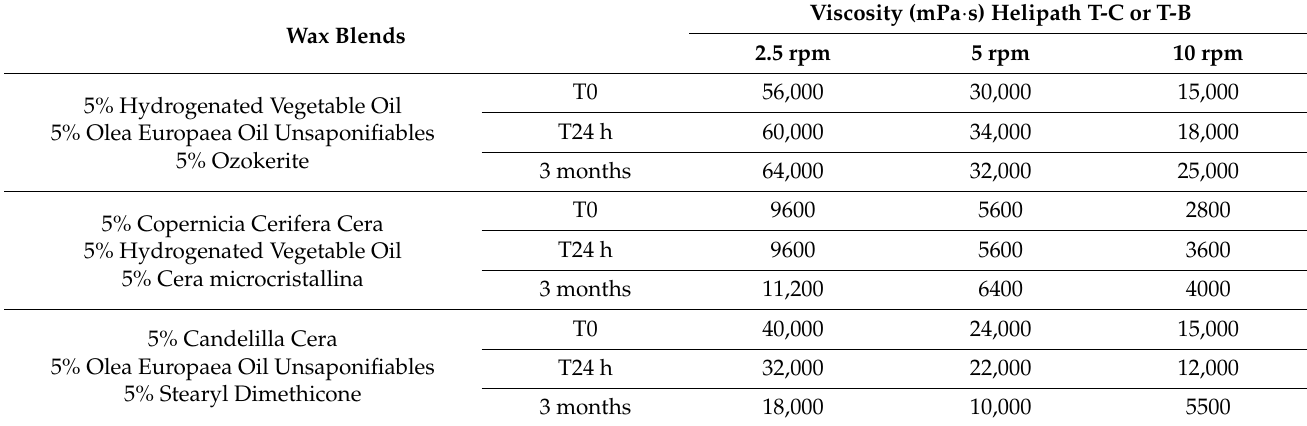
Table 6. Viscosity values of the new oil with blends of three waxes at T0, T24 h, and after 3 months.